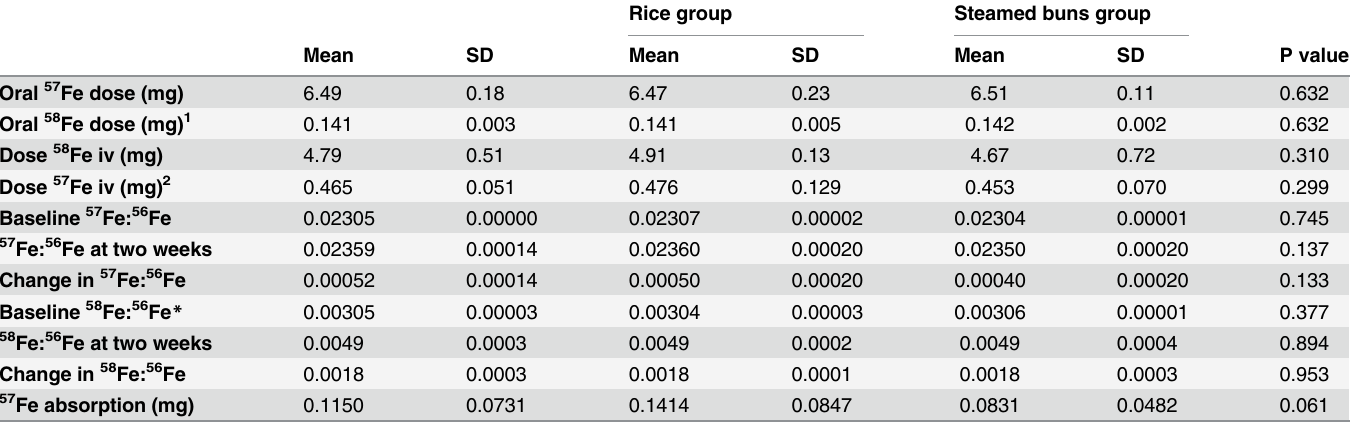
Table 5. Erythrocyte iron isotopic enrichment and iron absorption (mean ± SD).